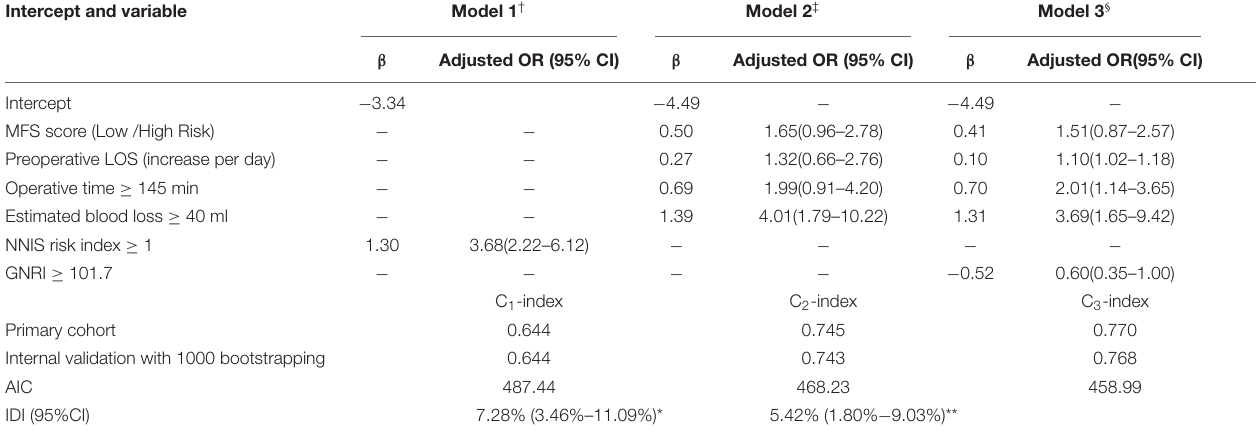
TABLE 3 | Prediction effect of the three models.